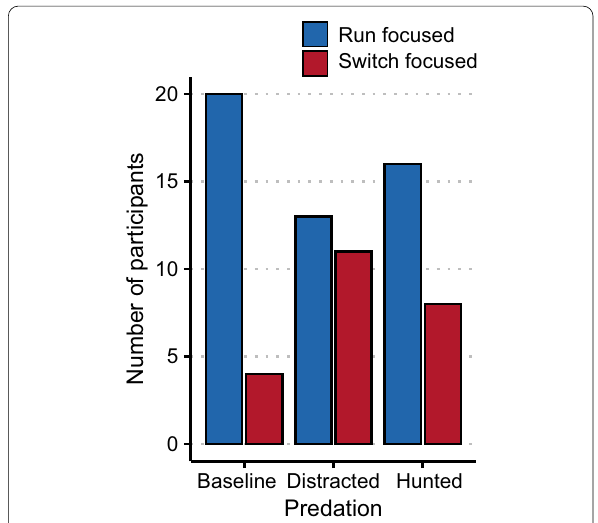
Fig. 8 Frequency of foraging strategy as a function of Predation group in Experiment 2. See text for details